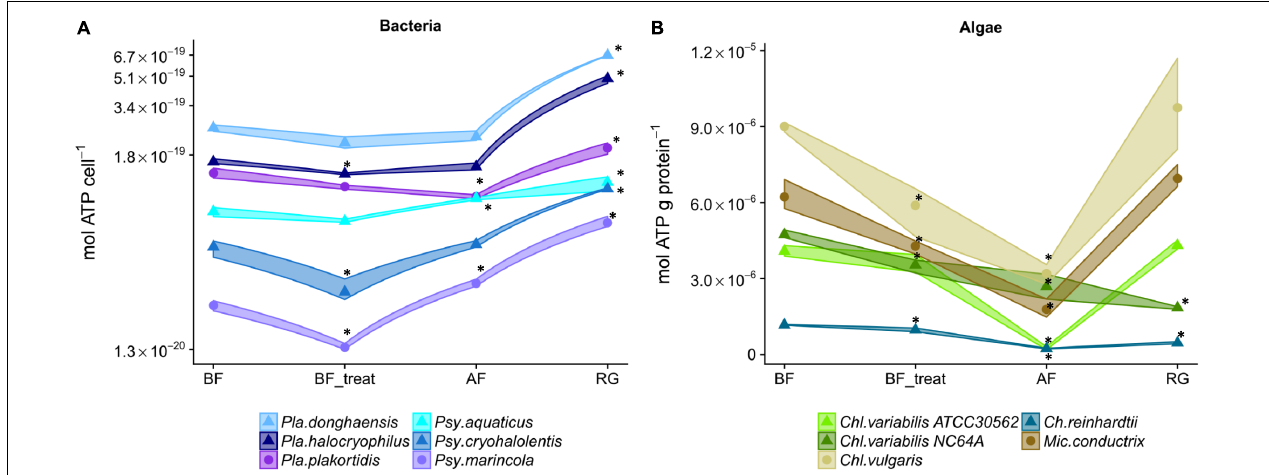
FIGURE 2 | Strain-specific alterations in intracellular ATP levels during cryostress experiments of bacteria and green algae. ATP content of cells of individual strains before freezing (BF), after the addition of a cryoprotectant (BF_treat), after freezing and thawing (AF) and after a regrowth phase (RG). Depicted are the means of three biological replicates with 95% confidence intervals presented as ribbons. (A) Response of the six different bacterial strains. (B) Response of the five different strains of green algae. (cid:78) psychrotolerant bacteria/cryotolerant algae, • mesophilic bacteria/cryosensitive algae. ∗ denotes values that were significantly different ( p < 0.05) from the BF value of the respective strain. Pla. , Planococcus ; Psy. , Psychrobacter ; Ch. , Chlamydomonas ; Chl. , Chlorella ; Mic., Micractinium.